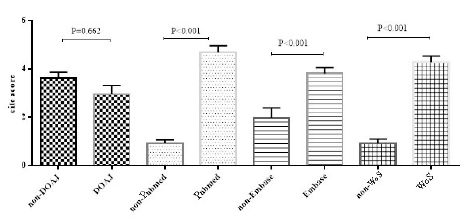
Figure 1. Effect of being covered by